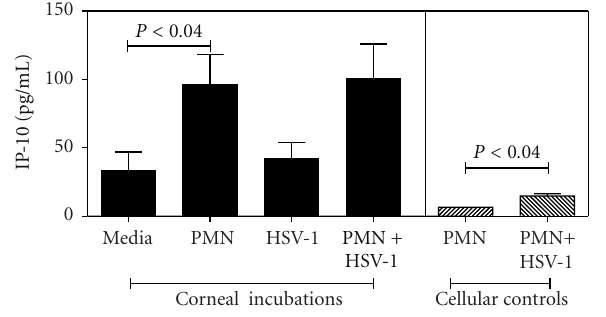
Figure 8: Corneal cells communicate with neutrophils leading to the production of IP-10 during ex vivo incubation of human corneas. 4 mm corneal buttons from human donor tissue were incubated in 500 μ L serum-free media at 37 ◦ C, 5% CO 2 for 24h. Where indicated corneal buttons were incubated in the presence of 1 × 10 6 neutrophils and/or HSV-1 at a M.O.I. = 1. Cell controls were included to monitor IP-10 production in the absence of corneal tissue. IP-10 levels are shown as pg/mL of